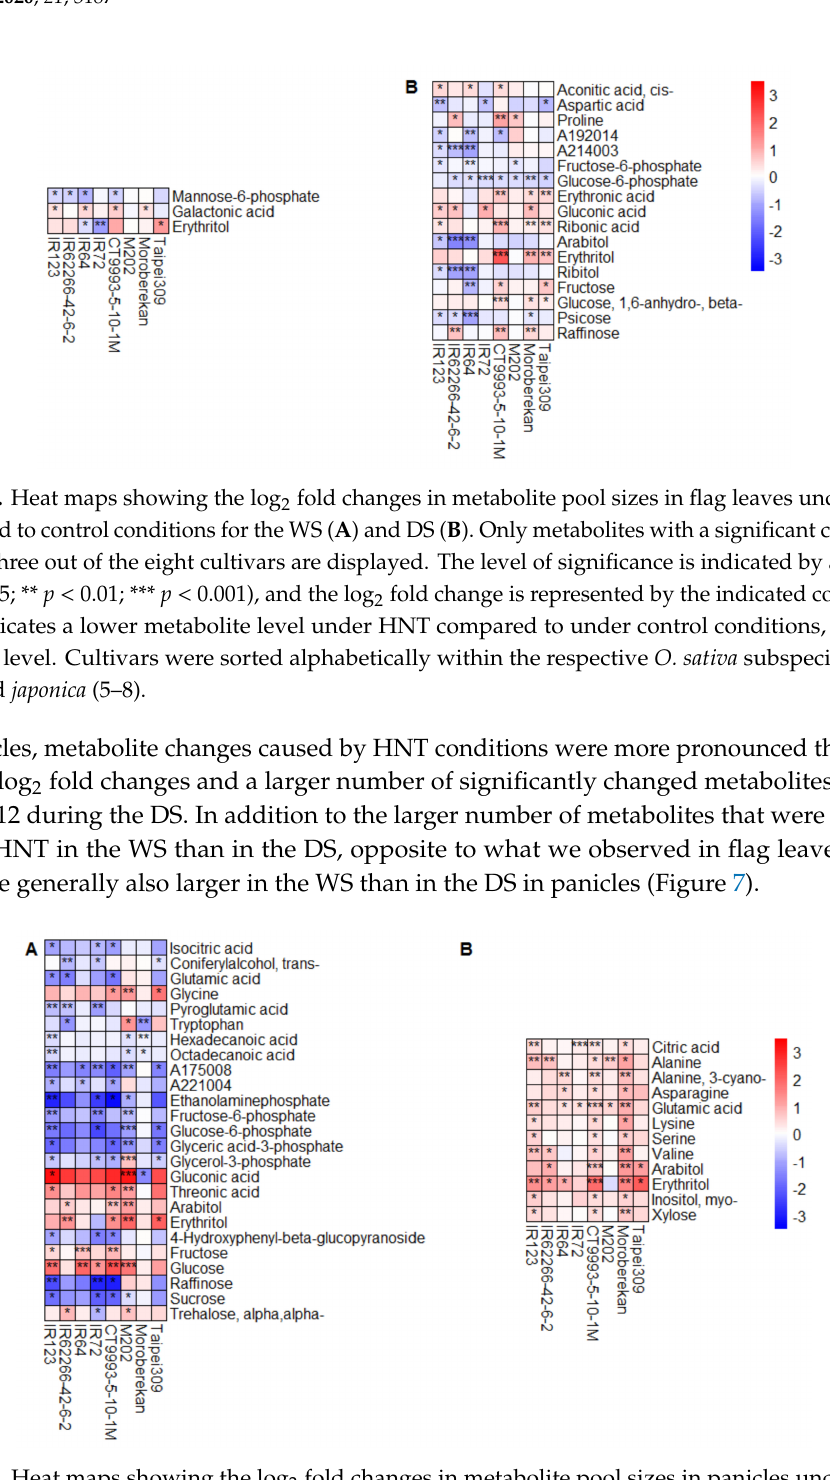
Figure 7. Heat maps showing the log 2 fold changes in metabolite pool sizes in panicles under HNT compared to control conditions for the WS ( A ) and DS ( B ). Only metabolites with a significant change in at least three out of the eight cultivars are displayed. The level of significance is indicated by asterisks (* p < 0.05; ** p < 0.01; *** p < 0.001), and the log 2 fold change is represented by the indicated color code. Blue indicates a lower metabolite level under HNT compared to control conditions, and red, a higher level. Cultivars were sorted alphabetically within the respective O. sativa subspecies indica (1–4) and japonica